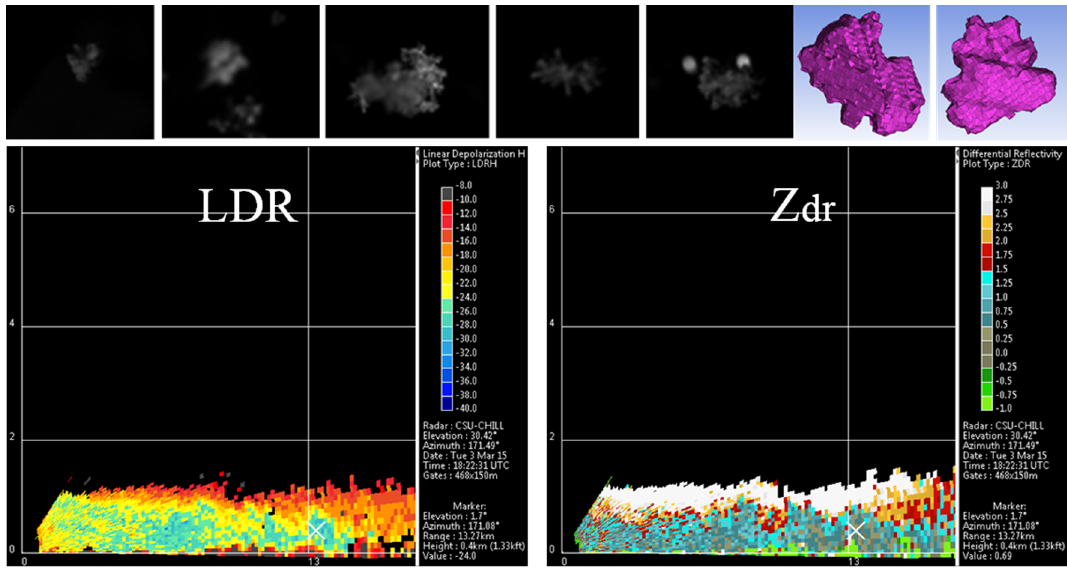
Figure 38. Some more illustrative results of MASC/MoM-SIE calculations for the 3 March 2015 event, in